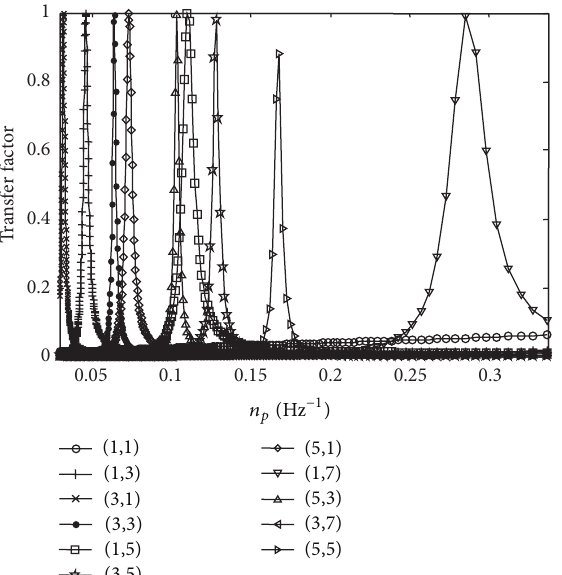
Figure 2: Transfer factors between the (0,0,1) enclosure mode and panelmodesasafunctionofpanelmodaldensity. 𝐿 𝑍 = 0.6 m, 𝑇 𝑎𝑁 = = 0.5 15 s, 𝑇 𝑝𝑀